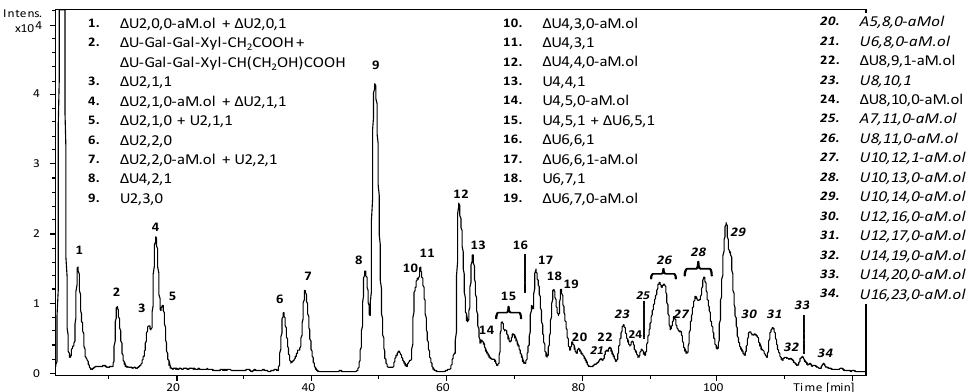
Figure 4. LC-MS profile (BPC) of a representative Fragmin ® sample (Frag-5) following digestion with heparinase III. Mass signals assignment of the main components is reported. Components identified in the parent sample, before the enzymatic digestion, are indicated in italic font. LC elution conditions: isocratic at 10% B for 5 min, linear gradient from 10% to 50% B in 55 min, linear gradient from 50% B to 90% B in 80 min, followed by column washing and reconditioning.